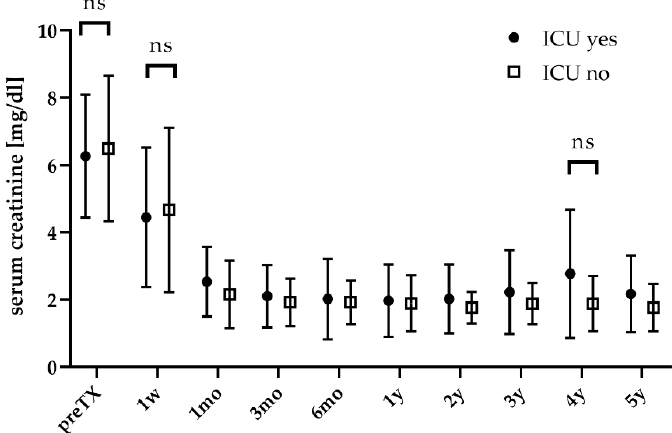
Figure 1. Graft function during follow-up. w: week; mo: month; y: year.